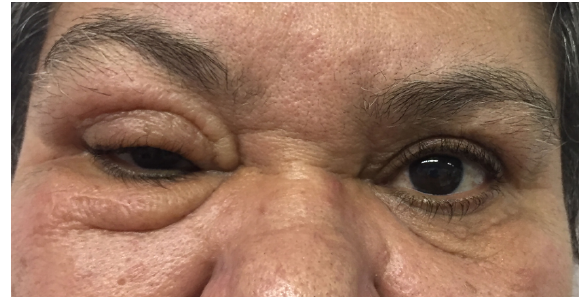
Figure 2: Recurrence of the eyelid edema on the right side